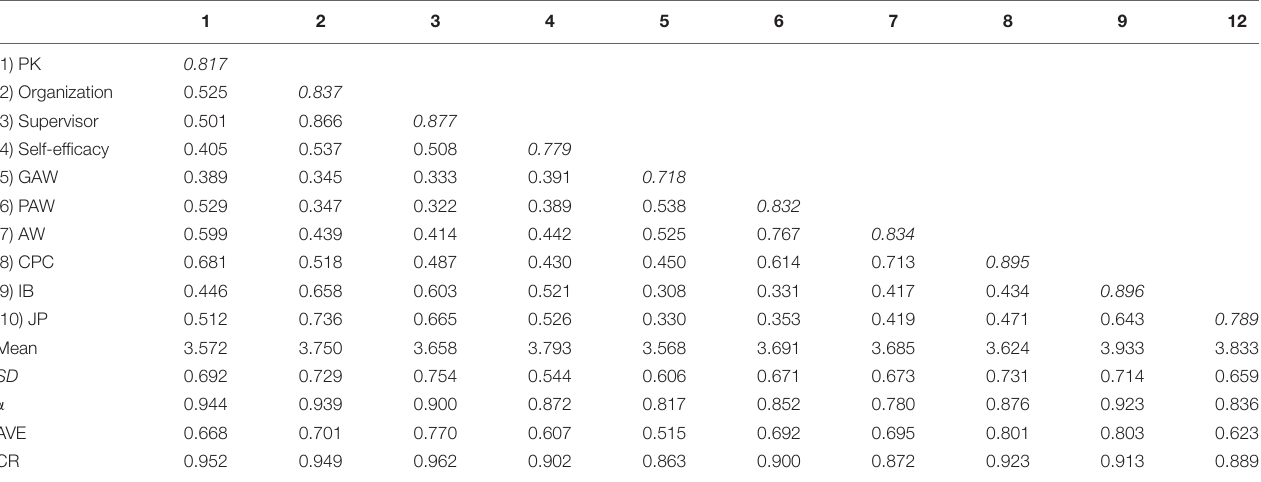
TABLE 3 | Measurement